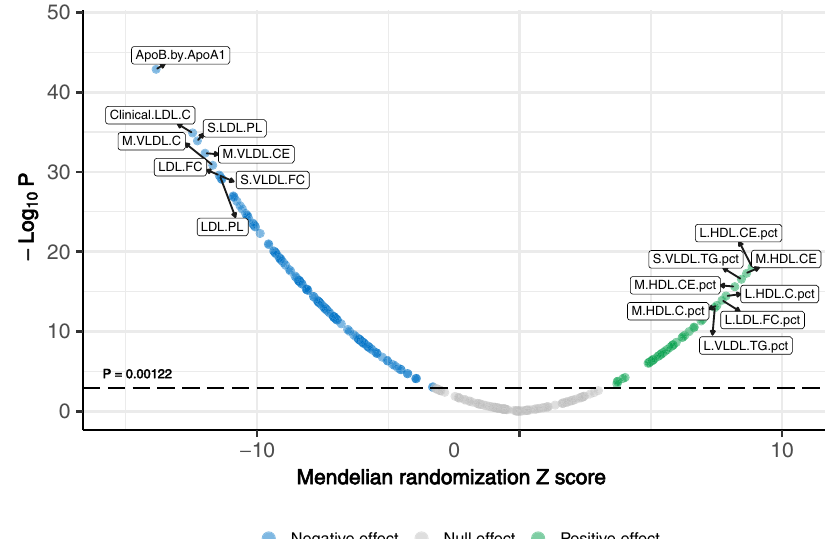
Fig. 3| Resultsofmetabolome-wideMRanalysisonmultivariatelongevity. MR effects of metabolic phenotypes on multivariate longevity. Metabolic phenotypes with signi fi cant, positive Z scores (beta/standard error) are predicted to increase multivariate longevity and vice versa. The eight most signi fi cant positive and negative associations are labeled with abbreviated codes, and the full name cor- responding to each code is contained in Supplementary Data 23. Green circles represent metabolic phenotypes that increase multivariate longevity and blue